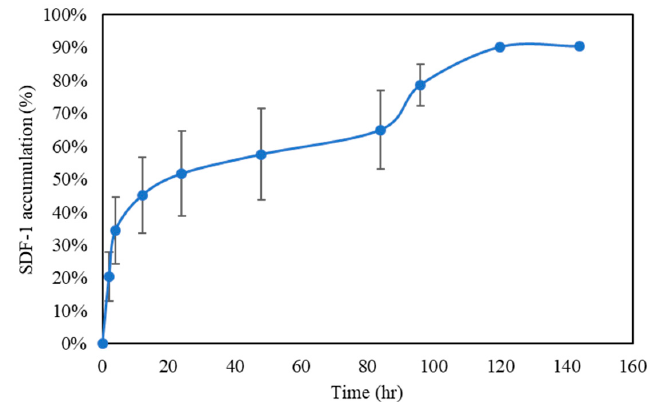
Figure 5. Stromal-cell-derived factor-1 (SDF-1) release profile ( n = 6). The Gel-HA / CS / HAP underwent a two-stage release. The first stage of release was caused by the SDF-1 molecules at the surface, and the second stage of release was caused by the degradation of the composite.